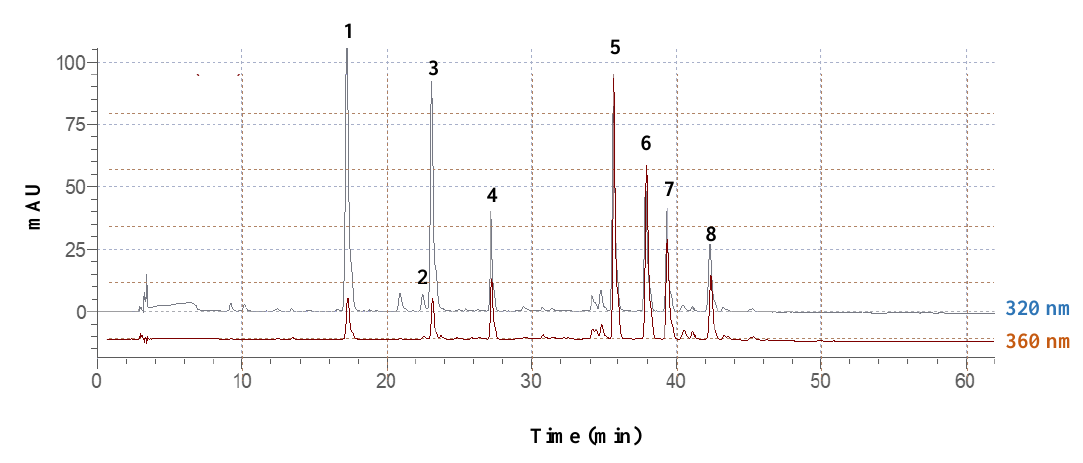
Table 7. Analytical spectrometric data of the major polyphenolic phytochemicals detected in the extracts of M. oleifera